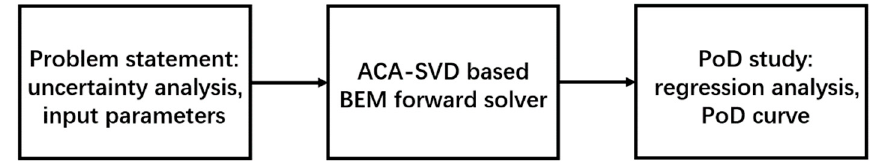
Figure 1. The procedure of the proposed fast forward solver based MAPoD study.